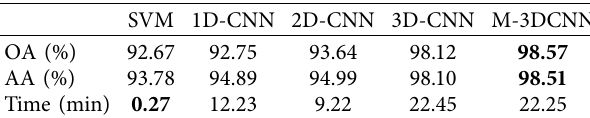
Table 4: Classification results of different